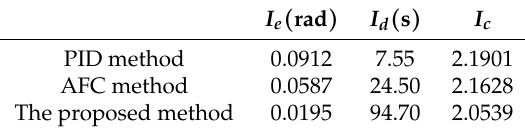
Table 3. Comparisons of quantitative evaluation indexes of the three